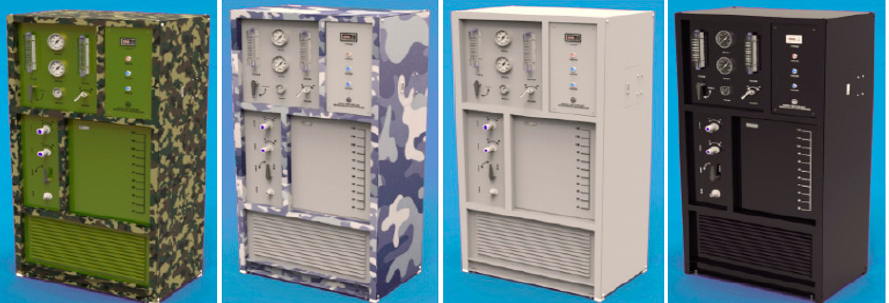
Figure 10. Seawater desalination devices for ship use [23].